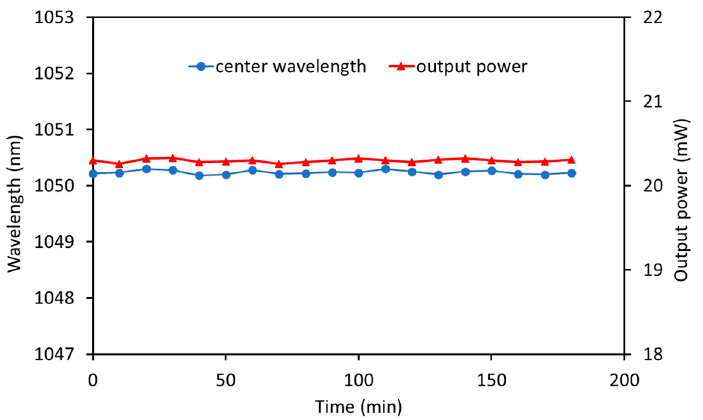
Figure 8. Stability test of mode-locked YDFL optical spectrum and output power. Table 1. Mode-locked YDFL based on Bi 2 Te 3 SA.